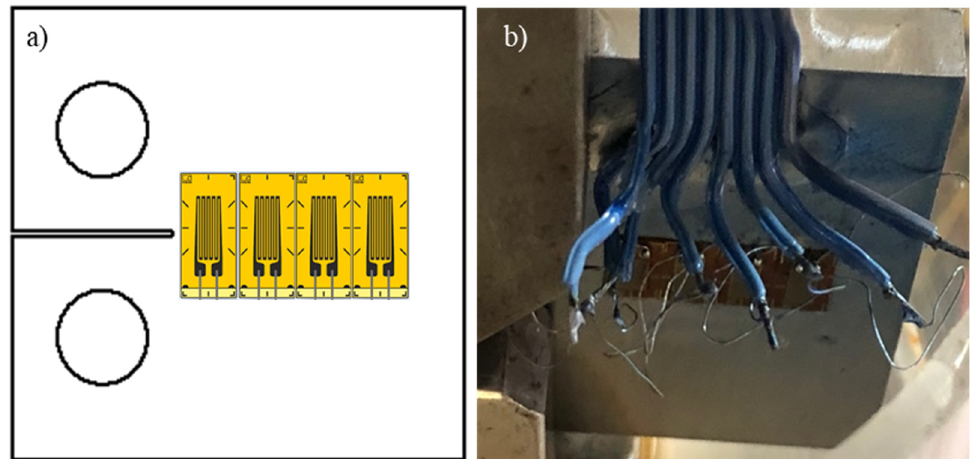
Figure 3. Load-displacement data register for FCGR tests under saline corrosion. ( a ) Schematic view of the apparatus, ( b ) Real view of the apparatus.